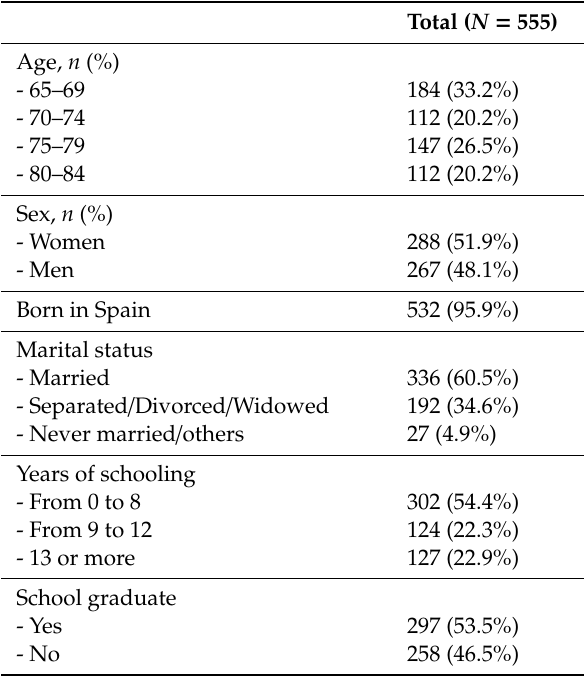
Table 1. Socio-demographic characteristics of the